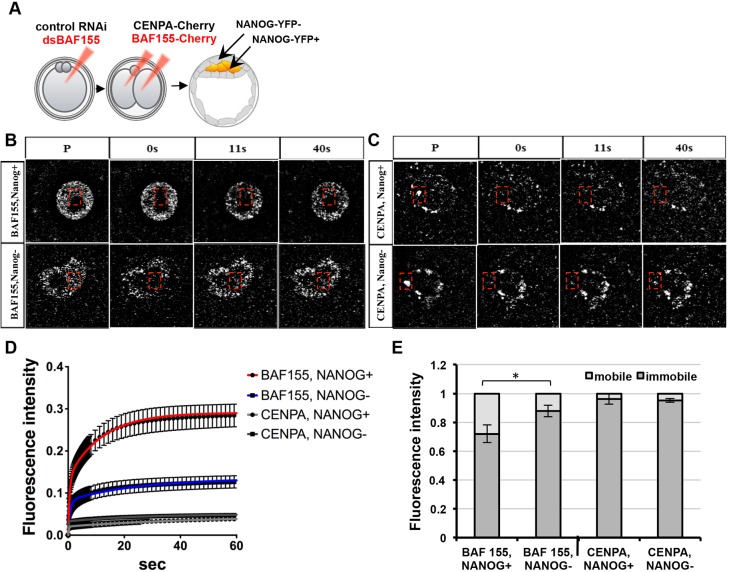
NANOG+ cells contain more mobile BAF155 than NANOG− cells. (A) Rescue conditions in Nanog-YFP transgenic embryos were applied to measure the live kinetics of BAF155 between the lineages at E4.5. The kinetics of CENPA were measured in embryos injected with control RNAi at the zygote stage (n=11). (B,C) The recovery kinetics of BAF155 and CENPA were assessed in a rectangular region of nuclei after photobleaching. The fluorescence intensity was measured prior to photobleaching (P) and for 40 s during the recovery phase after photobleaching (0 s). (D) NANOG+ cells show greater recovery of BAF155 than NANOG− cells, whereas recovery of CENPA is similar. (E) NANOG− cells have a significantly higher immobile fraction of BAF155 protein (87.7±4.3%) than NANOG+ cells (72.06±6.2%); *P<0.05, F-test. The difference in the size of the immobile fraction of CENPA between NANOG− (95.17±1.2%) and NANOG+ (96.31±3.6%) cells was not statistically significant (P>0.05, F-test). Error bars represent s.e.m.